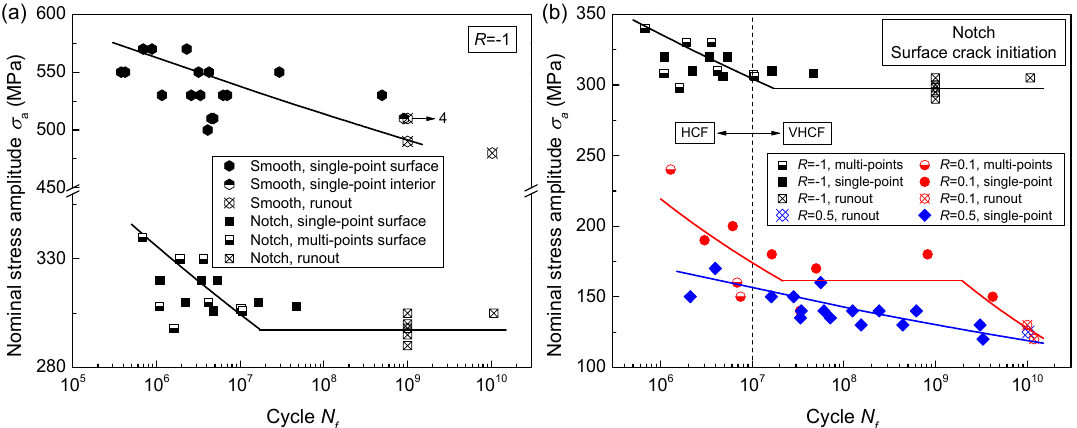
Figure 3. ( a ) S ‐ N data and curves for the smooth specimen and the notched specimen at R = − 1, and ( b ) S ‐ N data and curves for the notched specimen at R = − 1, 0.1 and 0.5. The nominal stress amplitude was obtained by dividing the applied force by the minimum cross ‐ sectional area. (Single ‐ point: crack initiation with single ‐ point; multi ‐ points: crack initiation with multi ‐ points; runout: no broken; the numeral at the right side of the arrow indicates the quantity of same test results.).